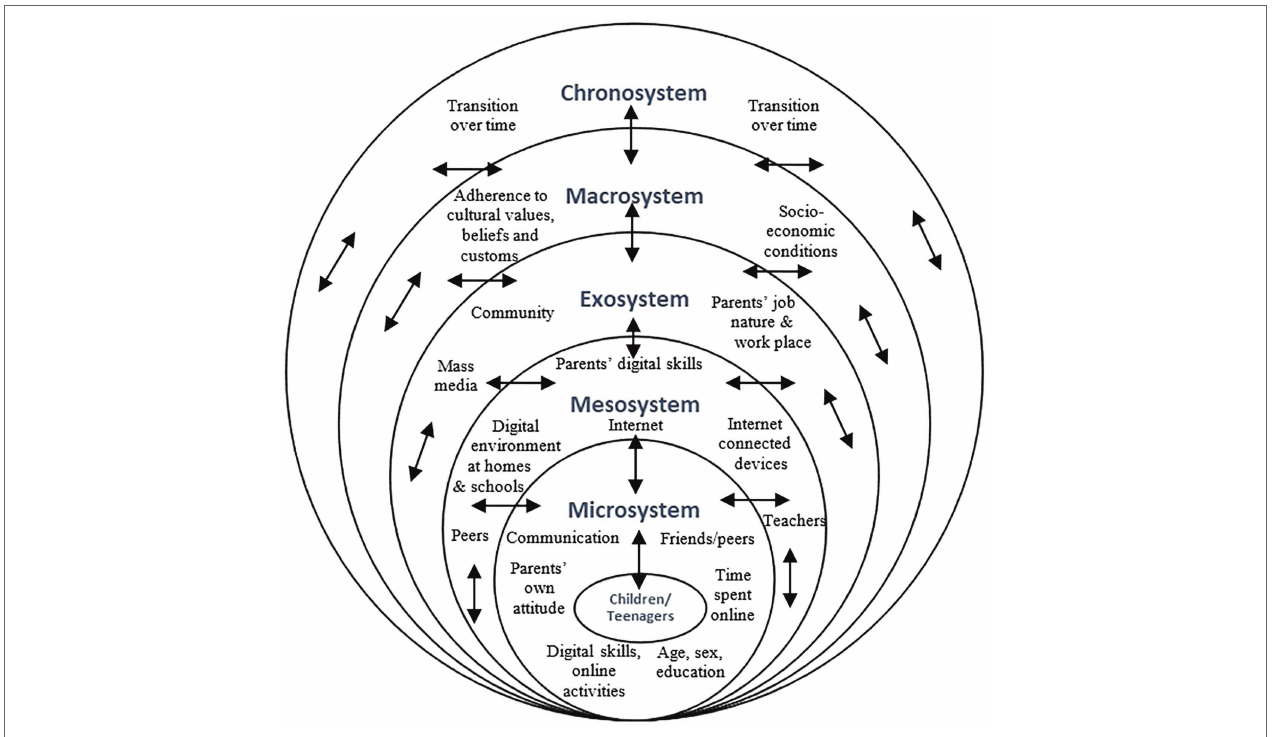
FIGURE 1 | Internet-related ecological